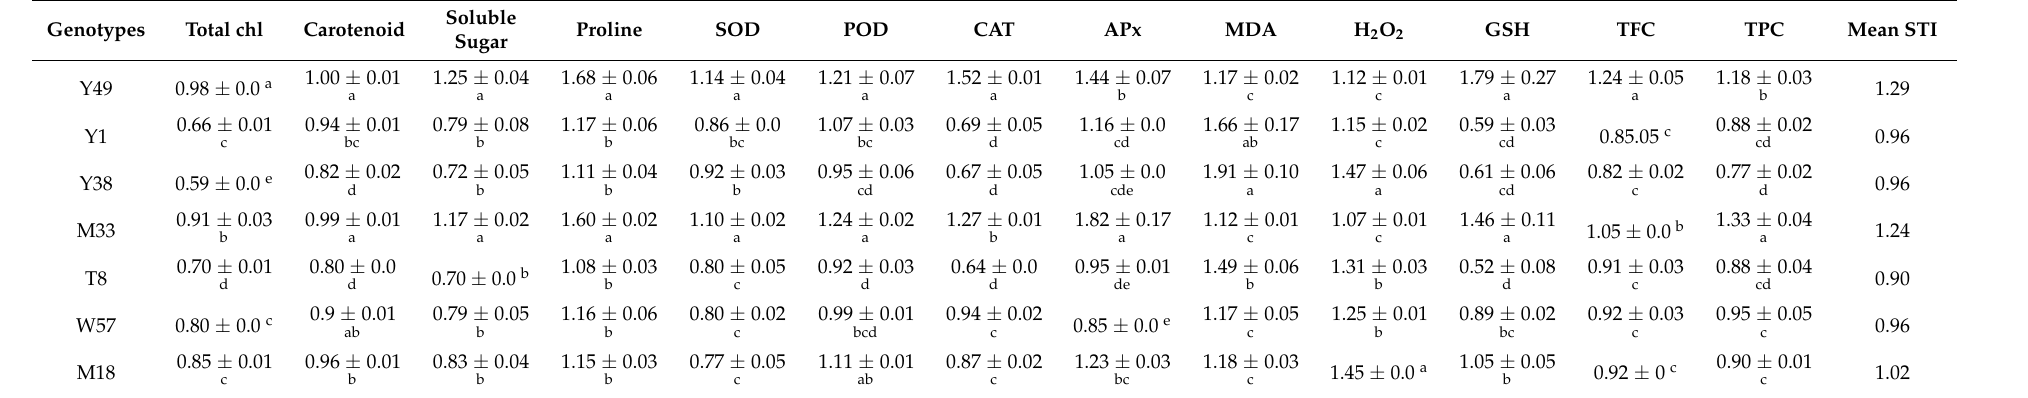
Table 3. Stress tolerance index (STI) with their